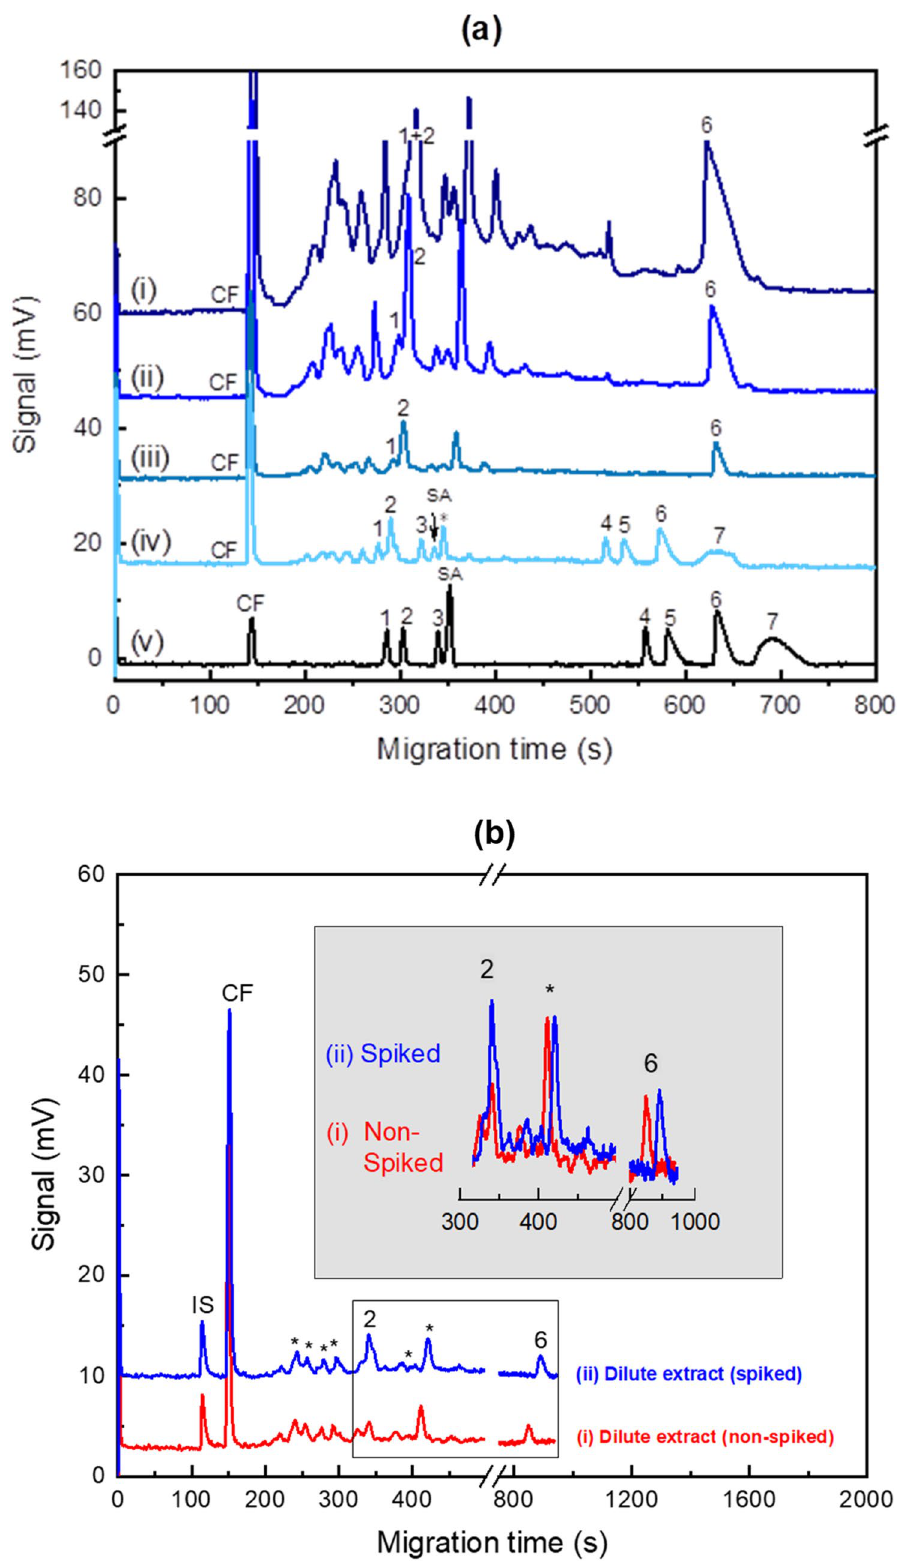
Fig. 3 a Electropherograms for different dilution factors of sample T1. (i) Tenfold dilu- tion, (ii) 20-fold dilution, (iii) 60-fold dilution, (iv) 60-fold dilution spiked with 50 µM PHPA, 3.5 µM PCA, 15 µM PHBA, 50 µM salicylic acid (SA), 12.5 µM CFA, 50 µM DHPA, 45 µM GLA, and 60 µM THBA and (v) mixture of standard phenolic acids and caffeine at 25 µM caffeine (CF), 100 µM PHPA, 7 µM PCA, 30 µM